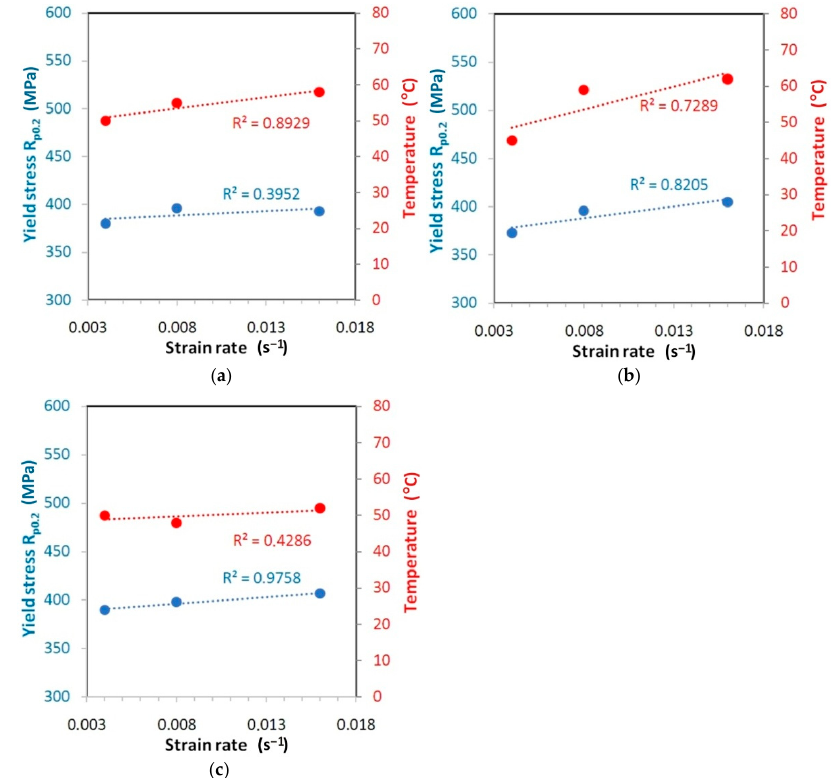
Figure 19. Correlation between the variation of the yield stress and measured temperature for the HX specimens cut at ( a ) 0° ( ε = 35.5–37.6), ( b ) 45° ( ε = 38.5–42) and ( c ) 90° ( ε = 34–35.8).